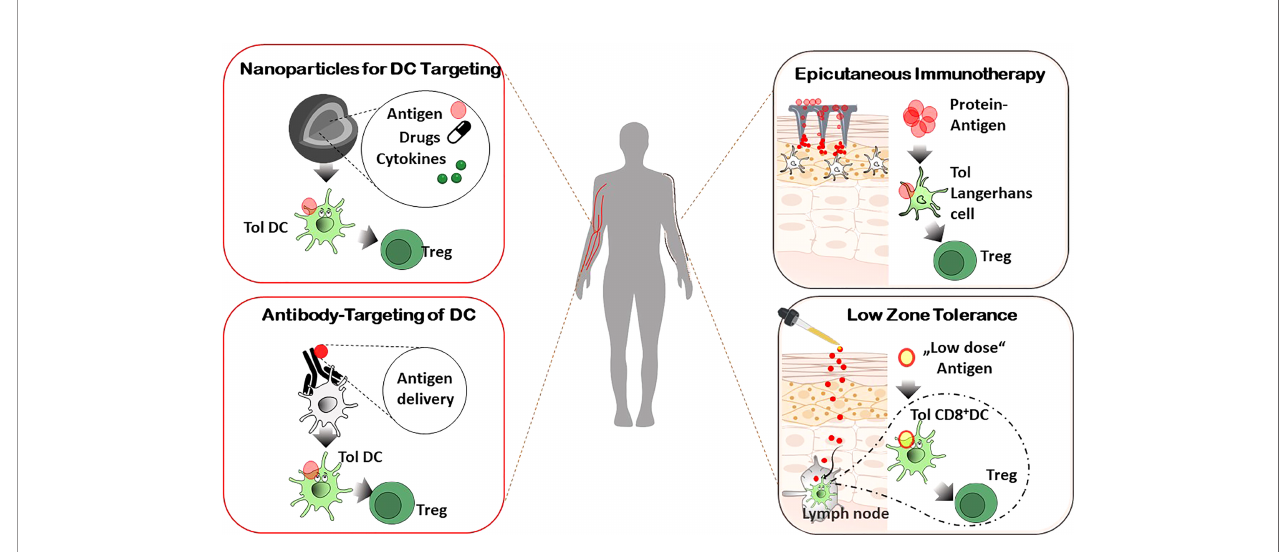
FIGURE 2 | In vivo targeting of DC for Treg induction. Systemic administration of speci fi cally designed nanoparticles or antibodies combined with antigen delivery for tolerogenic DC targeting in vivo , affects the resulting immune response of allergic and autoimmune diseases in an antigen-speci fi c manner. Epicutaneous application of antigens results in activation of tolerogenic LC in the skin (by dermal patches, Epicutaneous immunotherapy) or tolerogenic DC in skin draining lymph nodes (repetitive exposure to low doses of allergens, Low zone tolerance), respectively, and subsequent control of allergic immune reactions by